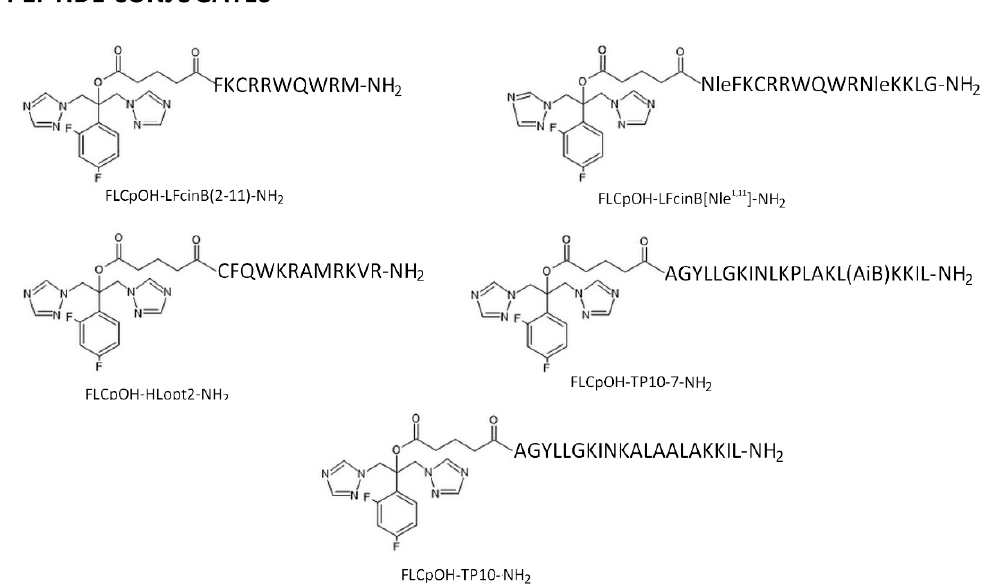
Figure 1. Chemical structures of synthesized conjugates and their constituents.